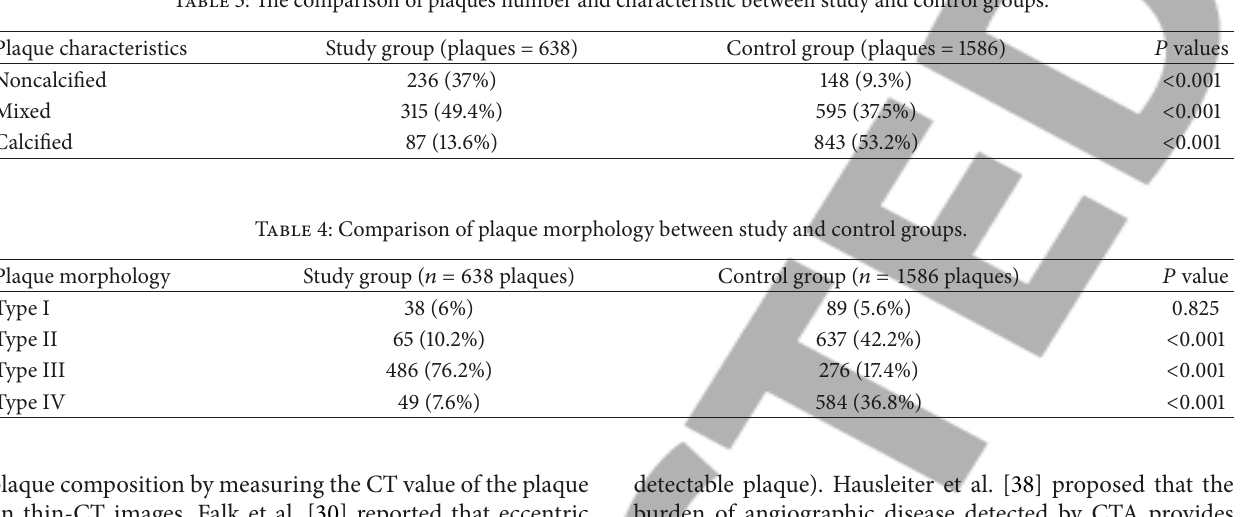
Table 3: The comparison of plaques number and characteristic between study and control groups.